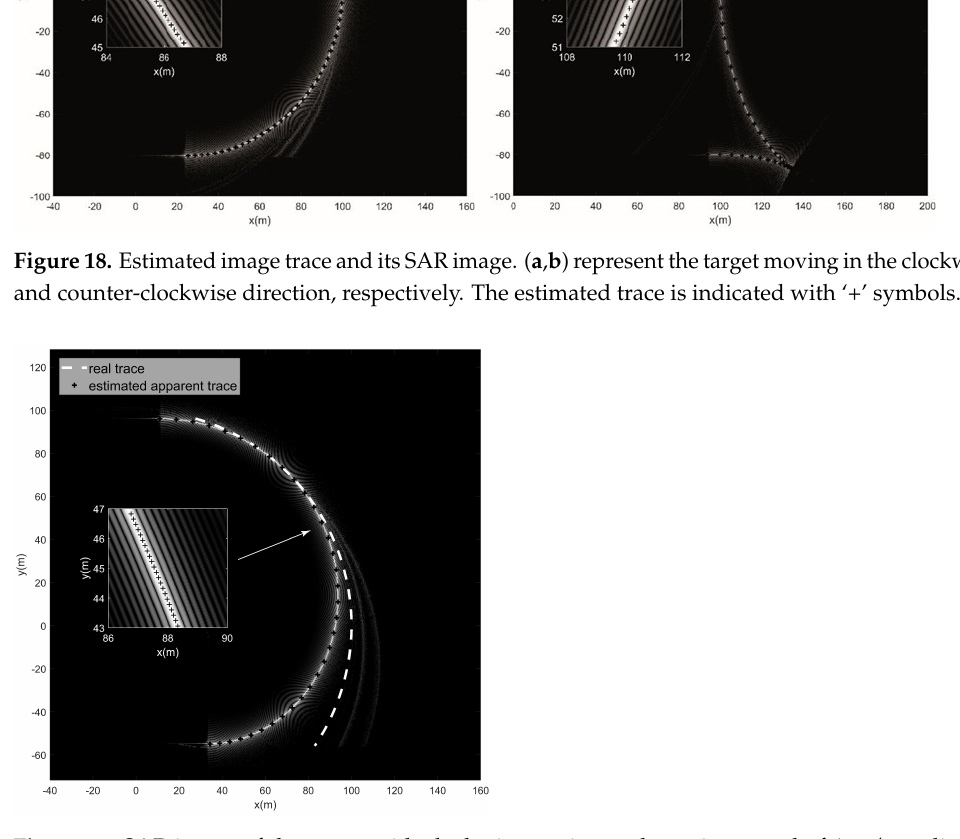
Figure 19. SAR image of the target with clockwise motion and rotating speed of 4 m/s, radius of 100 m, and angle (at t = 0) of ϕ = 20 ◦